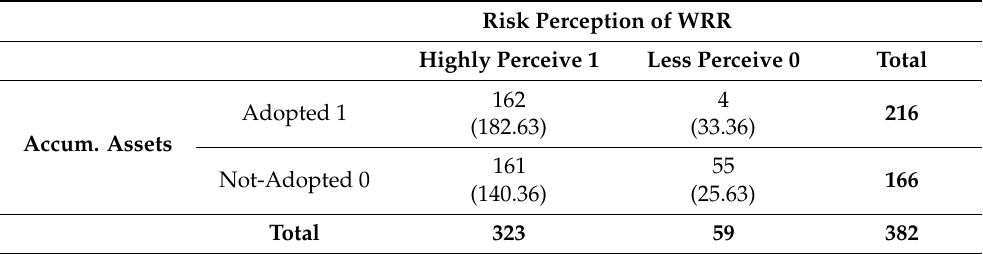
Table 11. Observed and Estimated Expected (in Parentheses) Counts for farmers’ risk perception of WRR and their choice to adopt accum. assets as a risk management